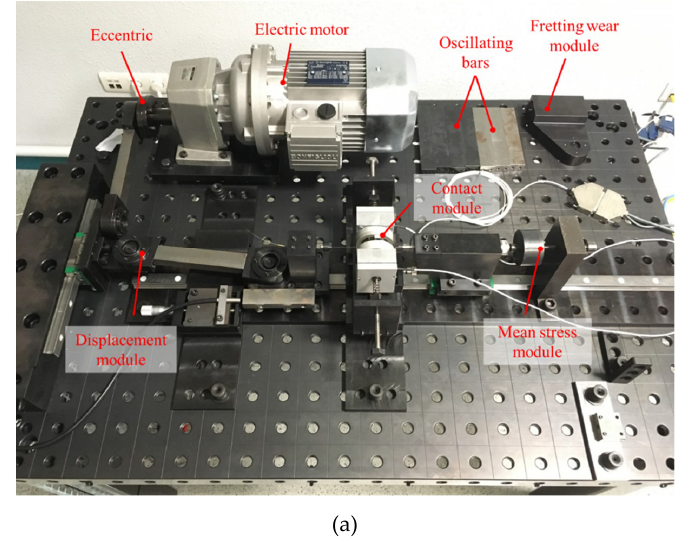
(b) Figure 3. ( a ) Developed fretting wear and fretting fatigue tribometer for thin steel wires. Combined fretting wear and fatigue configuration; ( b ) schematic of the fretting fatigue configuration. 2.1. Displacement Module A variety of actuator systems have been used in the literature to generate the short cyclic displacement, such as servo-hydraulic actuators [16], piezo-electric actuators [17], or electro- mechanical actuators [2,3]. Servo-hydraulic actuators provide a very precise control of the displacement, since the system is very stiff. For short stroke, low mass and elevated frequency, piezo- electric actuators are a very good choice, however, fatigue life is dependent upon the displacement applied. On the other hand, electro-mechanical systems provide a cost effective solution with a very simple design. In the present tribotester, an electro-mechanical system has been used. Figure 4 shows the sketch of the displacement system. This design allows converting the rotational motion into a short reciprocating displacement. Due to the geometrical properties of the design, the fretting stroke amplitude is dependent on the angle θ (Equation (1), Figure 4). Two interchangeable oscillating bars allows obtaining the desired reciprocating displacement (δ app ).